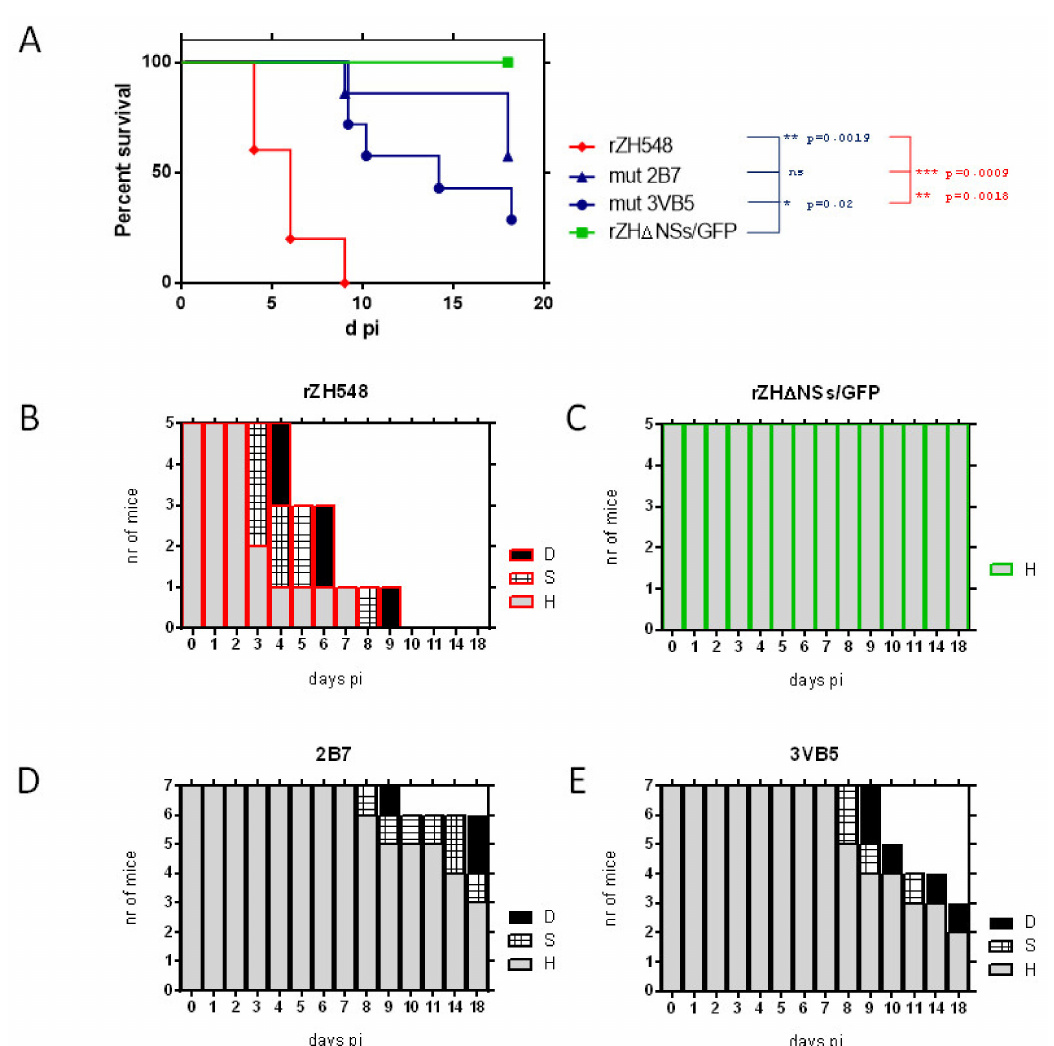
Figure 1. Analysis of the in vivo pathogenicity of the rZH548-P82L mutant viruses in BALB/c mice. 9–18-week-old male mice ( n = 5–7, equally distributed) were inoculated IP with 500 plaque-forming units (pfus) of the indicated viruses and both rZH548-P82L clones, 2B7 and 3VB5. Wild-type rZH548 (red) and rZH548 ∆ NSs::GFP (labeled as, rZH ∆ NSs/GFP, green) viruses were included as controls for virulence and attenuation, respectively. Animals were monitored up to 18 days. ( A ) Survival rates and ( B – E ) morbidity upon challenge with the indicated viruses. The graph represents the clinical status of each mouse: D (dead/euthanized): black bars; S (signs-sick), hatched bars; H (healthy), grey bars. The animal within the group rZH548 ∆ NSs::GFP euthanized at day 4 pi was excluded from the survival